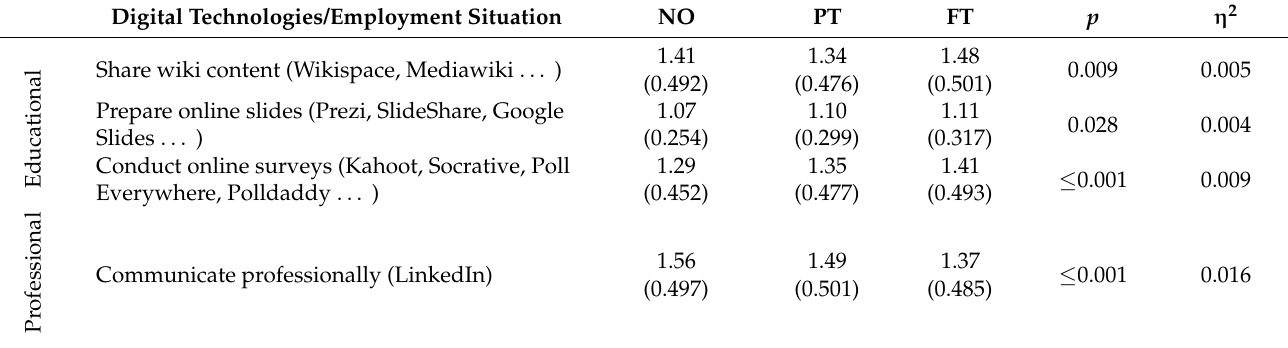
Table 6. Frequency of use according to the employment situation (no work, part-time PT, full time FT) as a fixed factor.